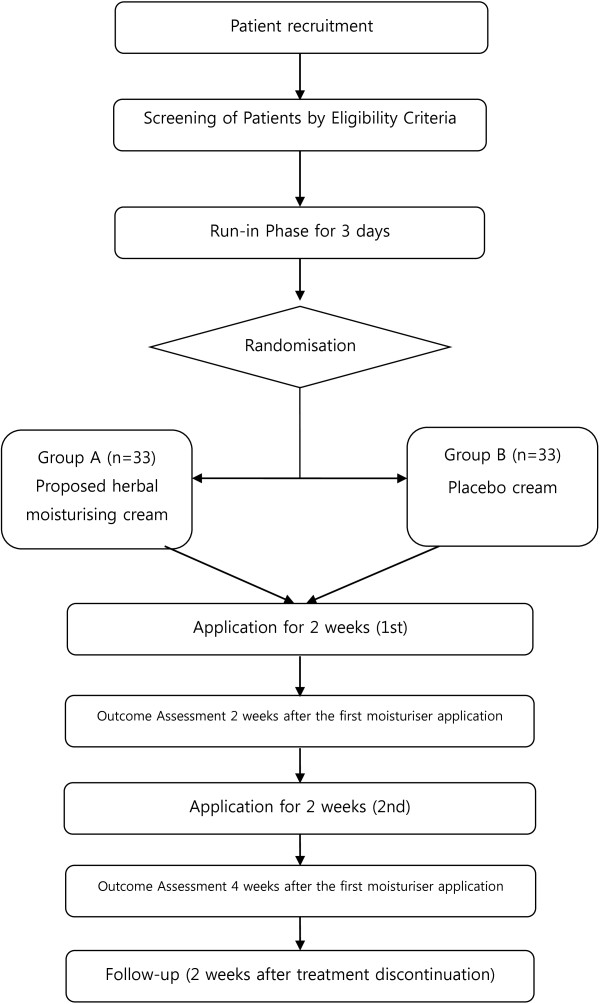
Study flow chart.